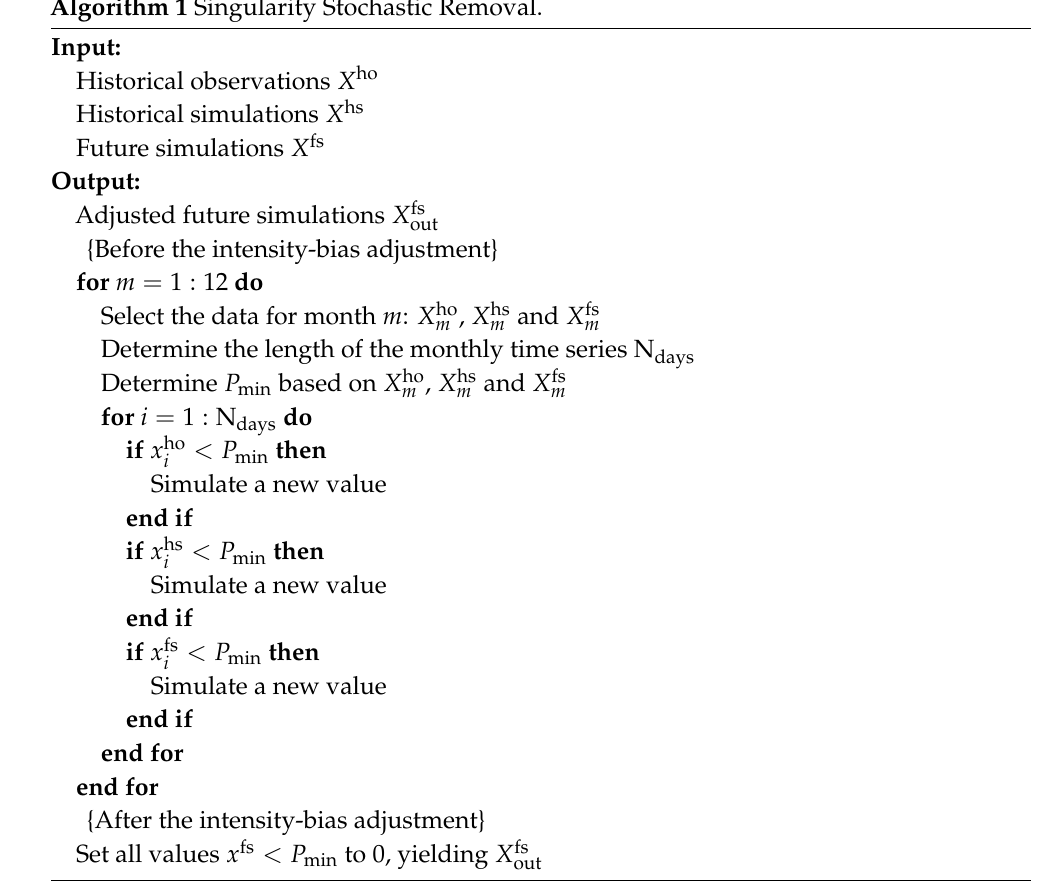
Algorithm 1 Singularity Stochastic